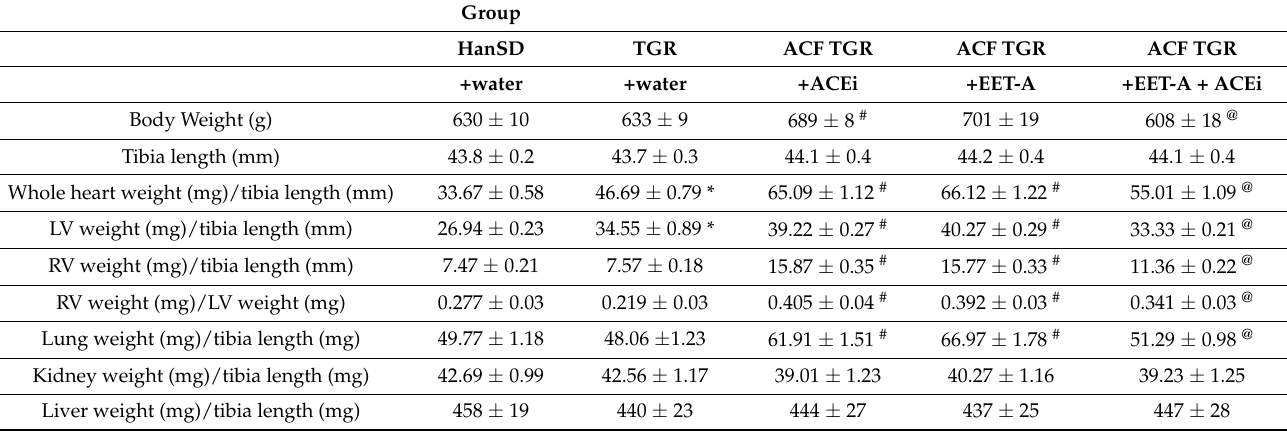
Table 4. Body and organ weights 22 weeks after creation of the aorto-caval fistula (ACF) or sham-operation and after 20-weeks’ treatment with 14,15-epoxyeicosatrienoic acids analog (EET-A) and angiotensin-converting enzyme inhibitor (ACEi), alone or combined with EET-A.